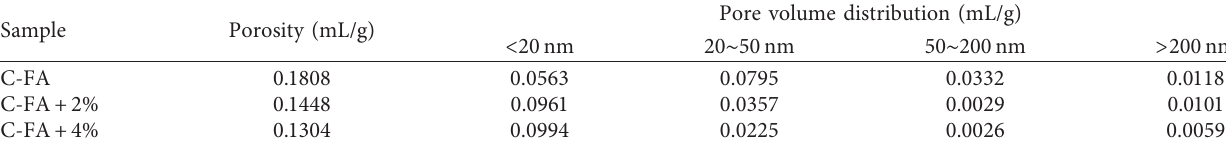
Table 3: Pore structure of C-FA with NS.